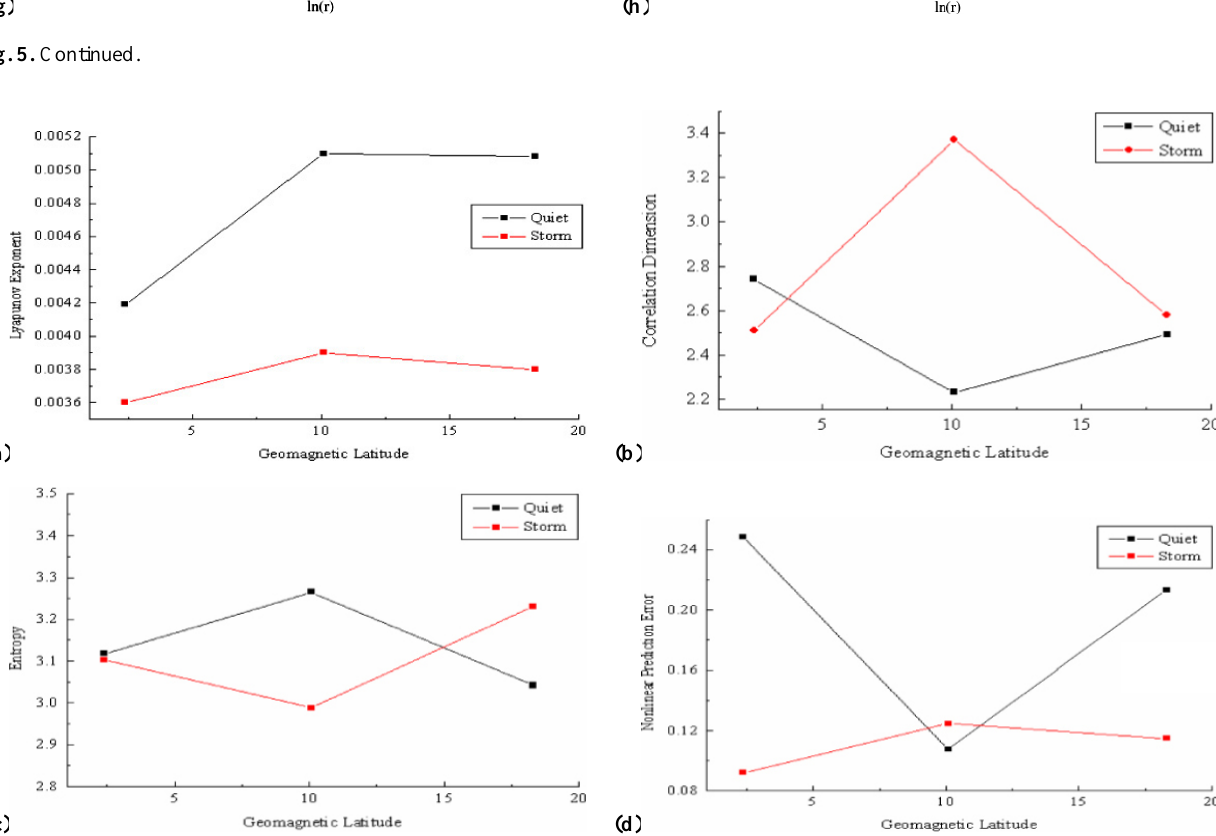
Fig. 6. Plots of latitudinal variation of (a) Lyapunov exponent, (b) correlation dimension, (c) entropy and (d) non linear prediction error, estimated from detrended TEC time